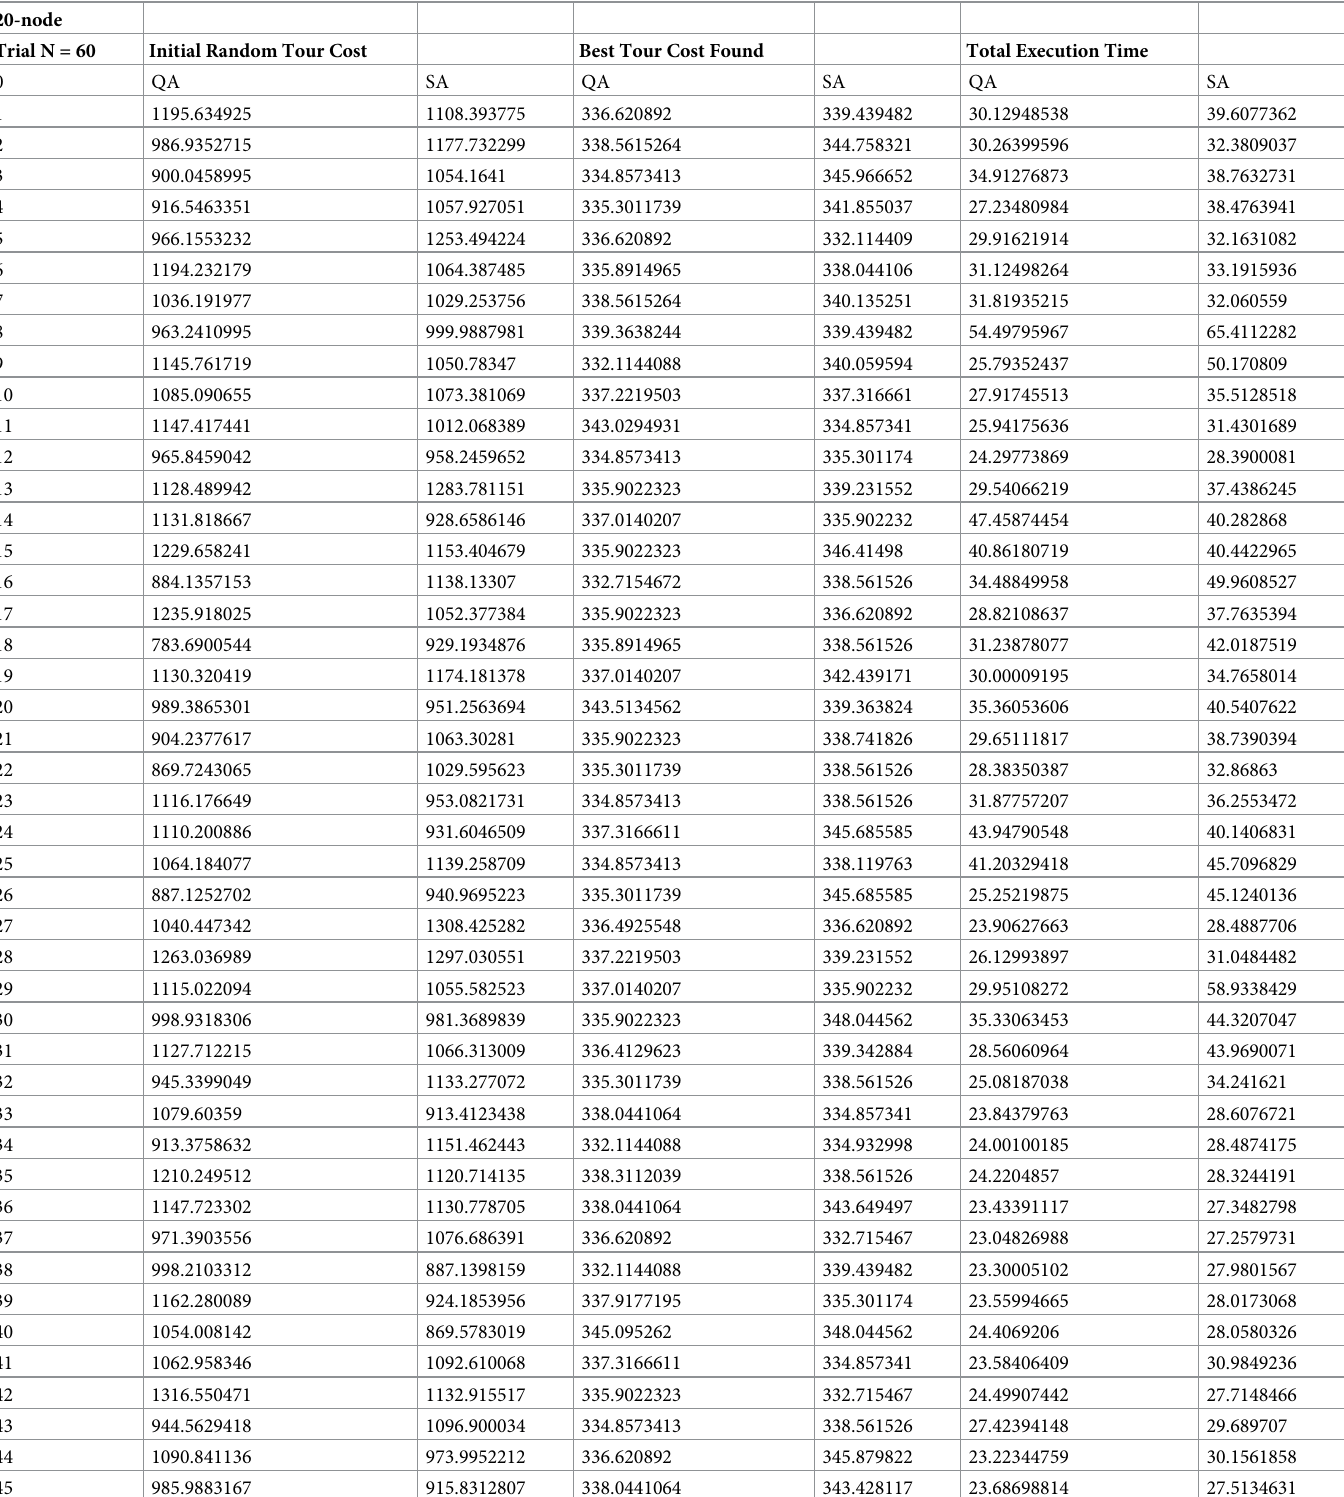
Table 22. Execution results for 20 nodes (n = 20) with samples size N =